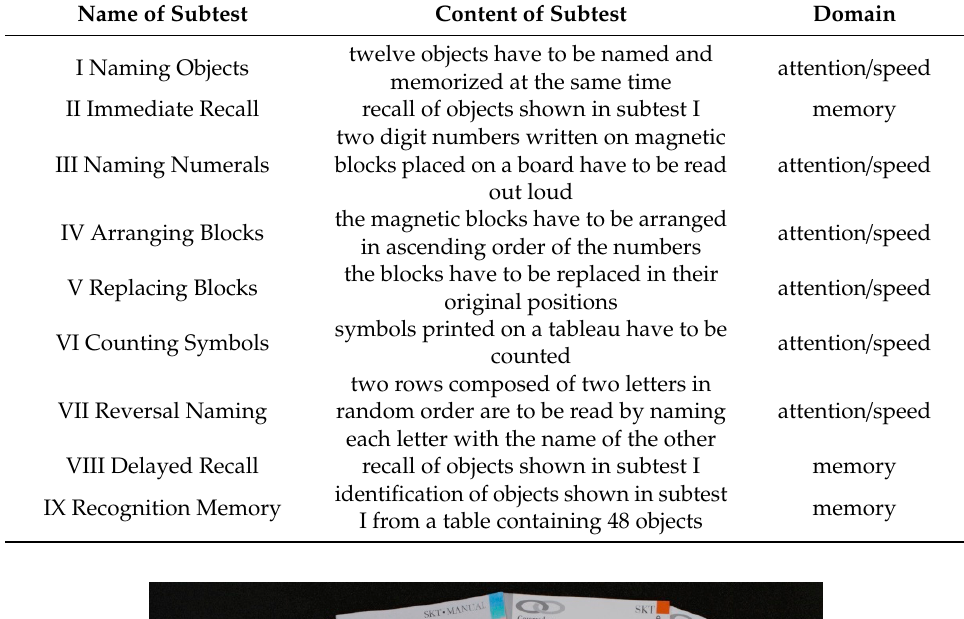
Table 1. Overview of the nine Syndrom ‐ Kurztest (SKT) subtests.